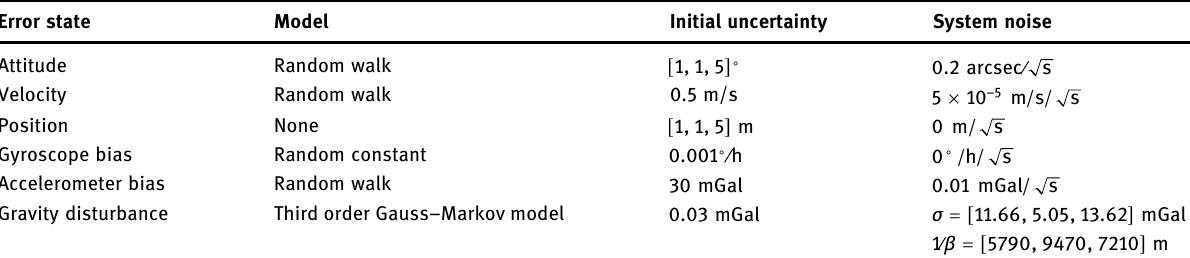
Table 1: Overview of error states modelled in the extended Kalman fi lter